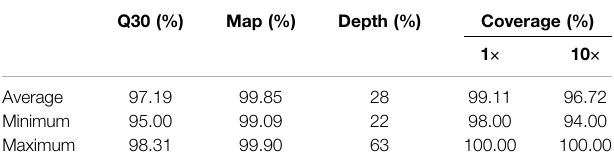
TABLE 1 | Summary of Quality control (QC).